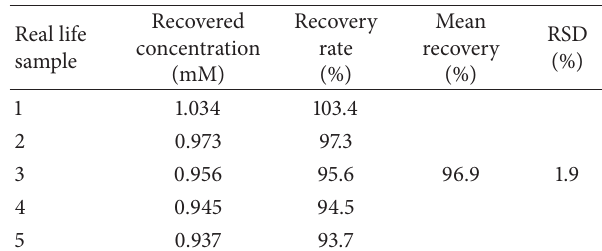
Table 2: Recovery study for the electrochemical process of com- mercial sample (Panadol). Five replicates of 1.0mM paracetamol determination at SWCNT/Ni-modified